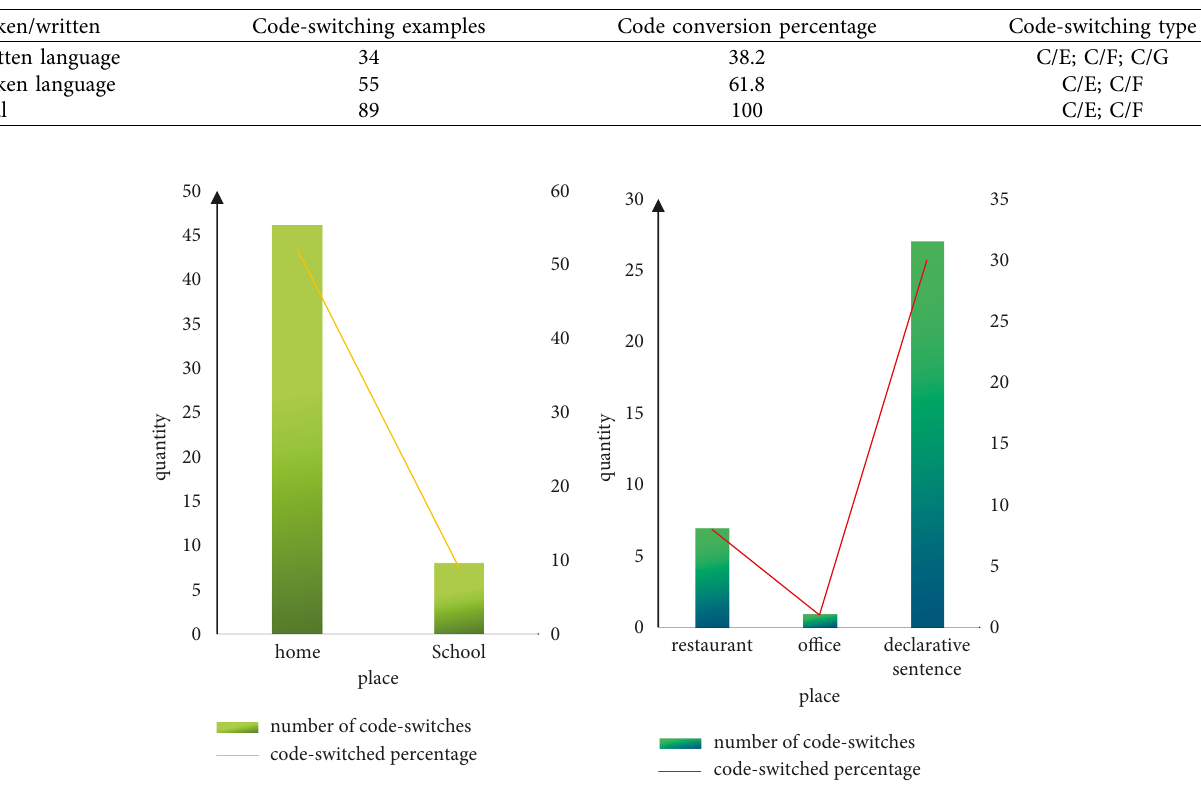
Figure 9: The distribution of code-switching in different